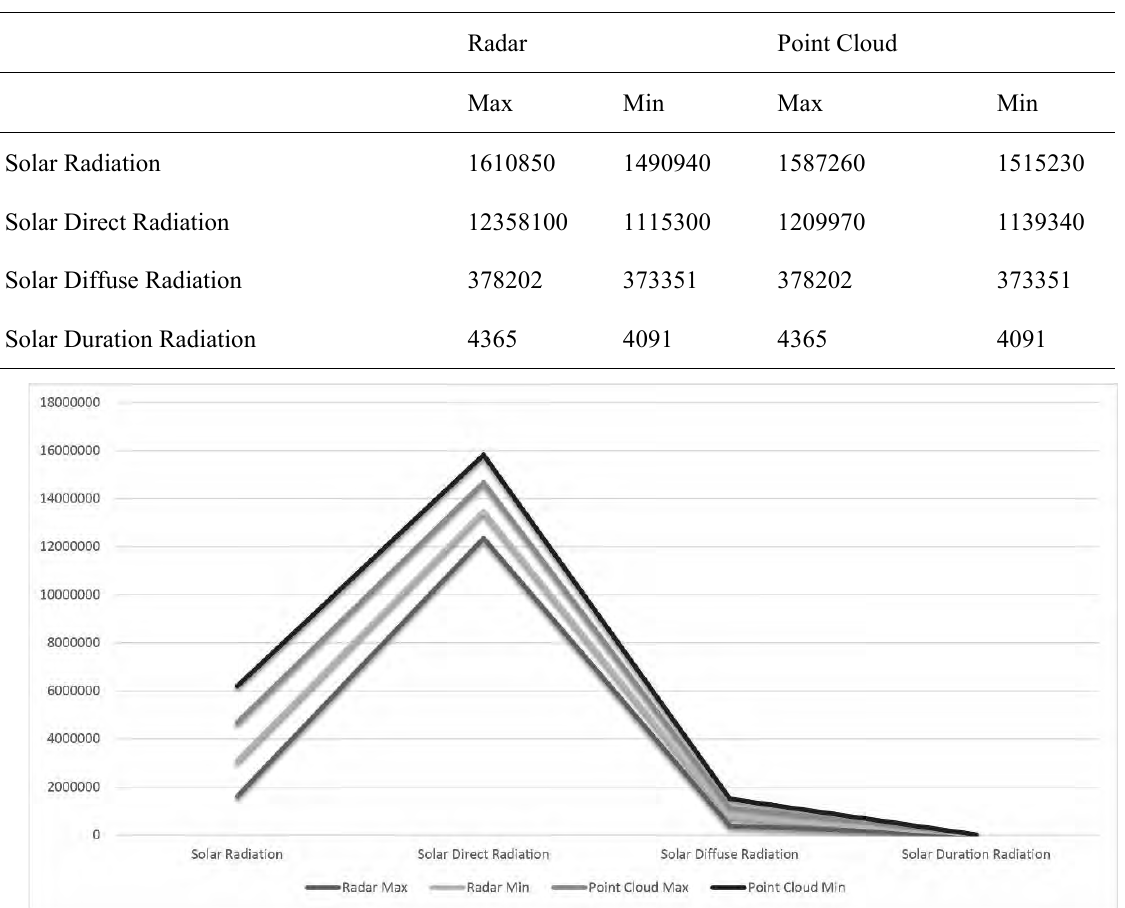
Table 5. Comparison of annual radiation in the point cloud and radar mode